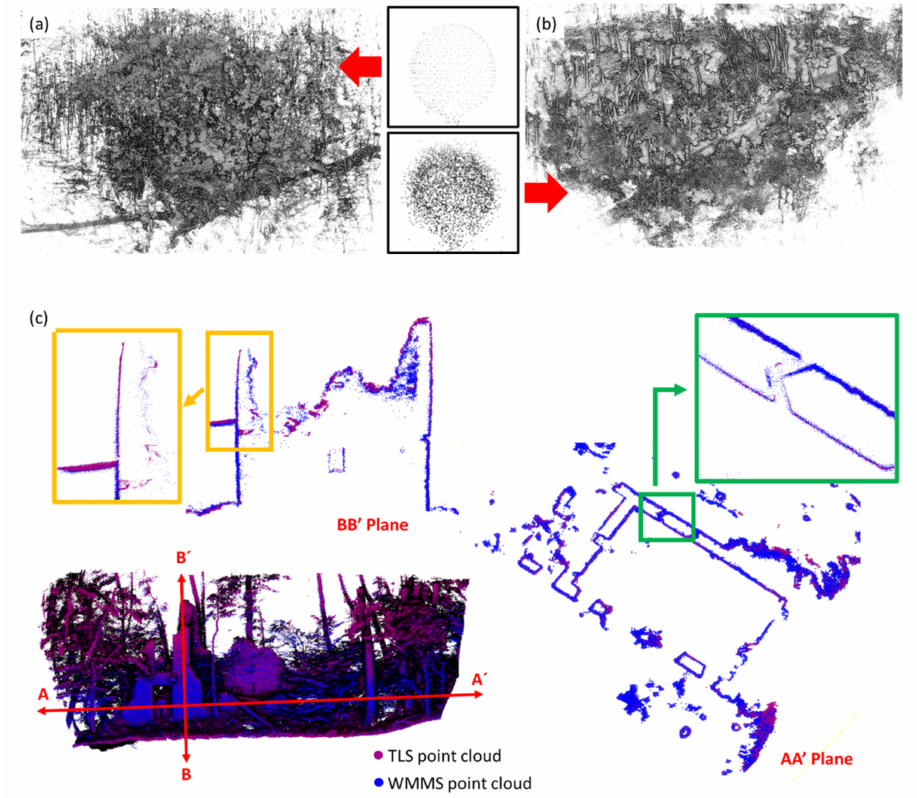
Figure 15. ( a ) TLS point cloud; ( b ) MMS point cloud; ( c ) comparison between the TLS and the MMSS point clouds—the TLS point cloud is in purple and the MMS point cloud is in blue. The AA’ Plane cuts the area of the building horizontally. BB’ Plane cuts the building